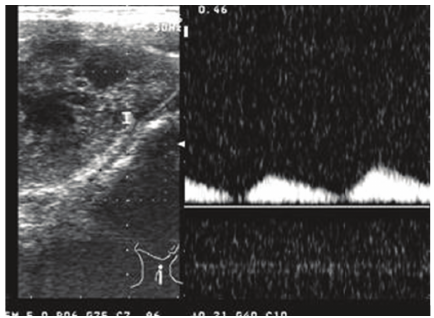
Figure 1: The Doppler ultrasonography of neck reveals a hetero- geneous predominantly hypoechoic mass on the left carotid space showing mild peripheral vascularity.